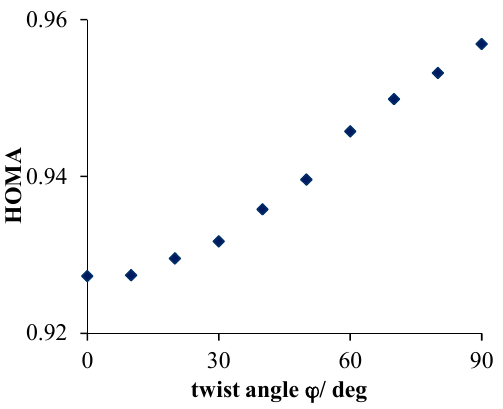
Figure 11. Dependences of HOMA values for p -nitroaniline (PNA) on rotation angle of NO 2 group, ϕ .